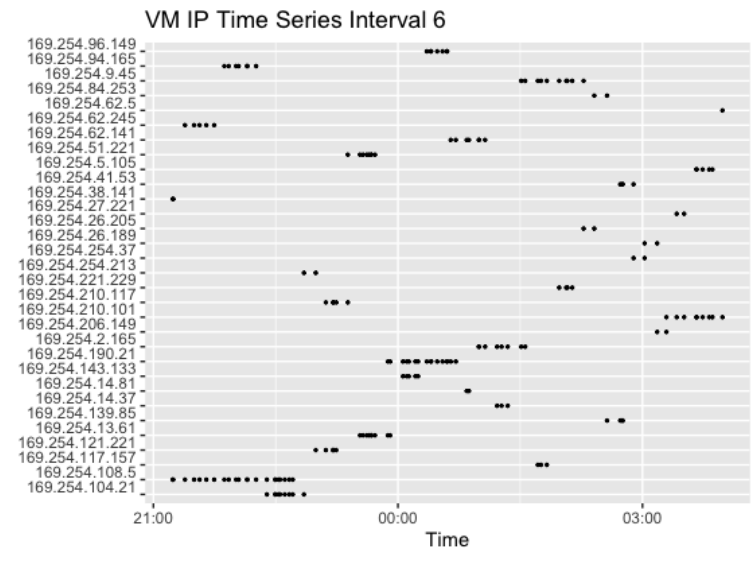
Figure 15. Interval 6 IP Distribution. Table 10. Interval Concurrency and Used